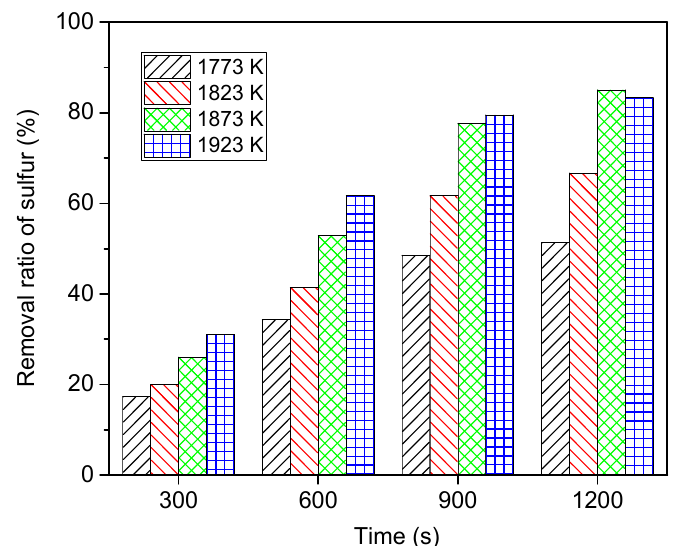
Figure 17. E ff ect of heating temperature on removal ratio of Figure 17. Effect of heating temperature on removal ratio of sulfur.